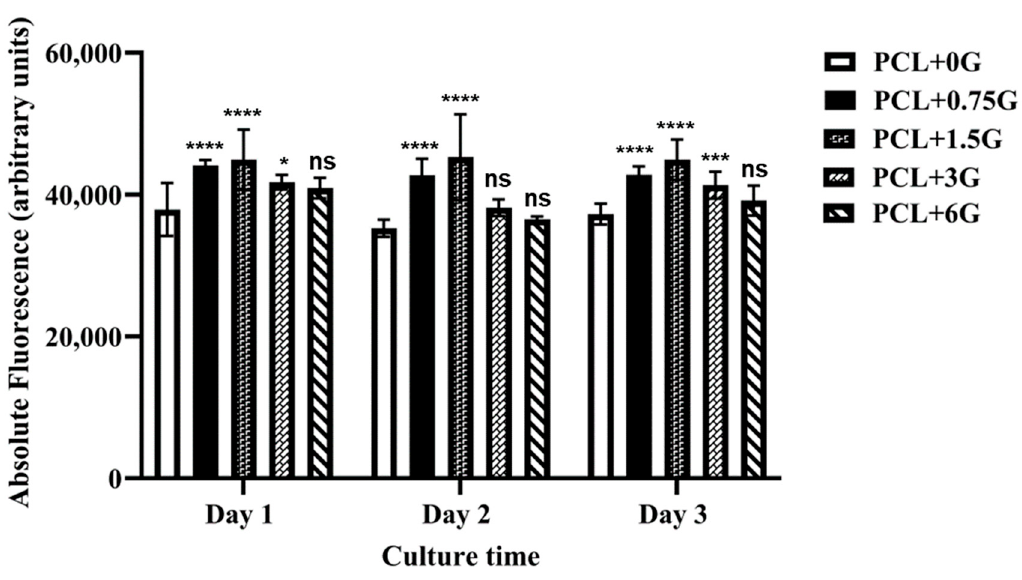
Figure 11. Mean Alamar Blue™ HS Cell Viability Assay data from HL-1 cells exposed to 3D-fabricated scaffolds, PCL, PCL+0.75G, PCL+1.5G, PCL+3G, and PCL+6G (see key) under standard culture conditions for 1, 2, and 3 days. Absolute fluorescence was measured at an excitation wavelength of 560 nm and an emission wavelength of 590 nm. Each scaffold type was tested in triplicate. Error bars represent standard deviation. Statistical significance in comparison with pure PCL, as determined by Dunnett’s multiple comparisons test, is represented by either not significant (ns), where p > 0.05, or significant, where p < 0.05. Increasing significance is represented by an increasing number of asterisks (* p < 0.05, *** p < 0.001, and **** p < 0.0001). The x-axis is Culture time (in days), and the y-axis is Absolute fluorescence in arbitrary units (a.u.).